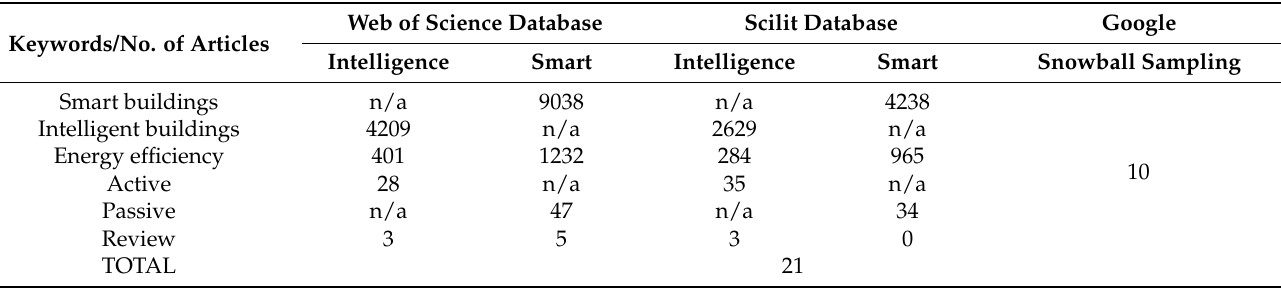
Table 1. Summary of publication selection